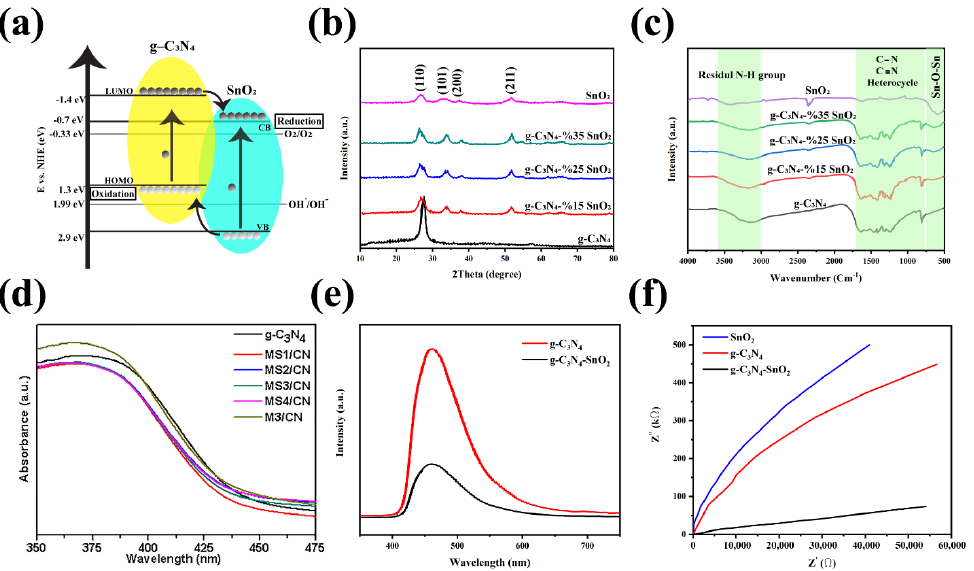
Figure 16. ( a ) Proposed structure of g-C 3 N 4 -SnO 2 heterojunction interface; ( b ) XRD patterns and ( c ) FT-IR spectra of SnO 2 , graphene-like C 3 N 4 , SnO 2 /g-C 3 N 4 composites (reproduce from Reference [295]); ( d ) UV-vis absorption spectra of g – C 3 N 4 -based samples (muscovite sheet(x)/SnO 2 /g-C 3 N 4 (MSx/CN), which x refers to the mass of MS powder), Copyright © 2022 Elsevier [298]; ( e ) PL spectra of g-C 3 N 4 and SnO 2 quantum dots-g-C 3 N 4 nanocomposite, Copyright © 2022 Elsevier [299]; ( f ) EIS Nyquist plots of the bare SnO 2 , g – C 3 N 4 , and SnO 2 -g-C 3 N 4 structure, Copyright © 2022 Elsevier [300].